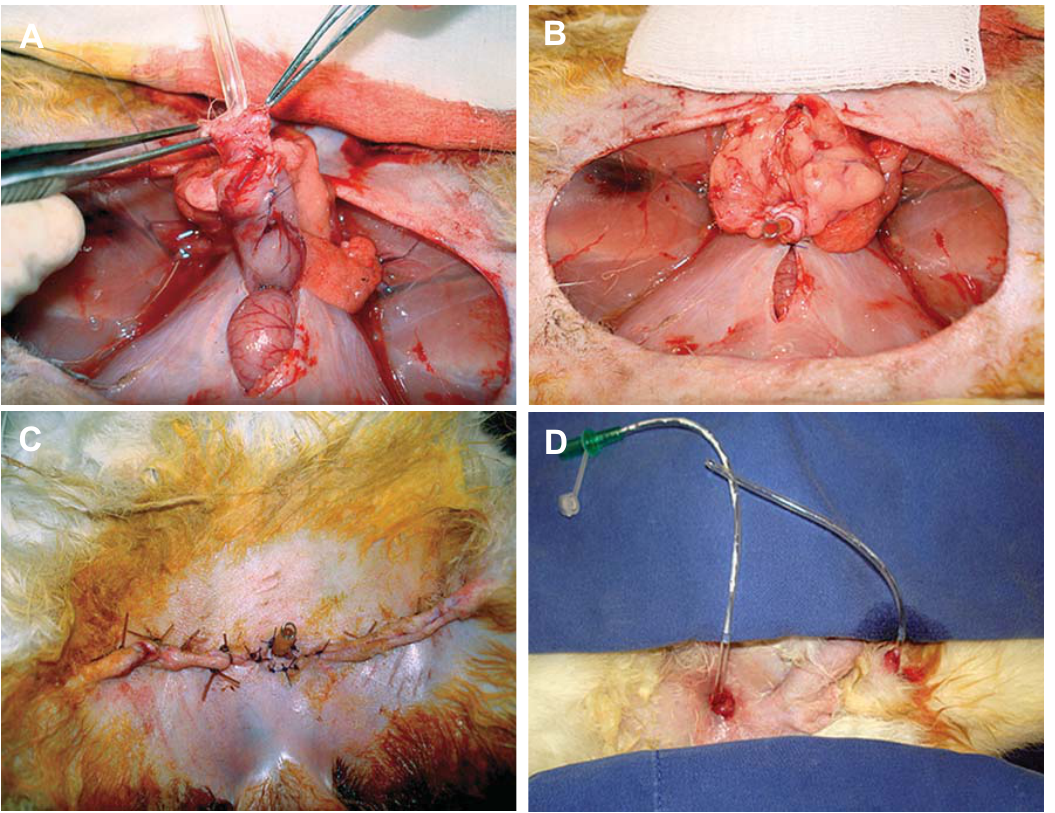
Figure 2 – (cid:36)(cid:81)(cid:68)(cid:86)(cid:87)(cid:82)(cid:80)(cid:82)(cid:86)(cid:76)(cid:86)(cid:3)(cid:82)(cid:73)(cid:3)(cid:87)(cid:75)(cid:72)(cid:3)(cid:87)(cid:88)(cid:69)(cid:72)(cid:3)(cid:76)(cid:81)(cid:3)(cid:87)(cid:75)(cid:72)(cid:3)(cid:69)(cid:79)(cid:68)(cid:71)(cid:71)(cid:72)(cid:85)(cid:3)(cid:68)(cid:81)(cid:71)(cid:3)(cid:191)(cid:81)(cid:68)(cid:79)(cid:3)(cid:68)(cid:86)(cid:83)(cid:72)(cid:70)(cid:87)(cid:3)(cid:82)(cid:73)(cid:3)(cid:87)(cid:75)(cid:72)(cid:3)(cid:86)(cid:87)(cid:82)(cid:80)(cid:68)(cid:17)(cid:3)(cid:49)(cid:82)(cid:87)(cid:76)(cid:70)(cid:72)(cid:3)(cid:87)(cid:75)(cid:68)(cid:87)(cid:3)(cid:68)(cid:3)(cid:70)(cid:68)(cid:87)(cid:75)(cid:72)(cid:87)(cid:72)(cid:85)(cid:3)(cid:76)(cid:86)(cid:3)(cid:76)(cid:81)(cid:86)(cid:72)(cid:85)(cid:87)(cid:72)(cid:71)(cid:3)(cid:87)(cid:75)(cid:85)(cid:82)(cid:88)(cid:74)(cid:75)(cid:3)(cid:87)(cid:75)(cid:72)(cid:3)(cid:86)(cid:87)(cid:82)(cid:80)(cid:68)(cid:3) (cid:68)(cid:81)(cid:71)(cid:3)(cid:72)(cid:91)(cid:76)(cid:87)(cid:86)(cid:3)(cid:87)(cid:75)(cid:85)(cid:82)(cid:88)(cid:74)(cid:75)(cid:3)(cid:87)(cid:75)(cid:72)(cid:3)(cid:88)(cid:85)(cid:72)(cid:87)(cid:75)(cid:85)(cid:68)(cid:3)(cid:83)(cid:85)(cid:82)(cid:89)(cid:76)(cid:81)(cid:74)(cid:3)(cid:83)(cid:68)(cid:87)(cid:72)(cid:81)(cid:70)(cid:92)(cid:3)(cid:82)(cid:73)(cid:3)(cid:87)(cid:75)(cid:72)(cid:3)(cid:70)(cid:75)(cid:68)(cid:81)(cid:81)(cid:72)(cid:79)(cid:17)